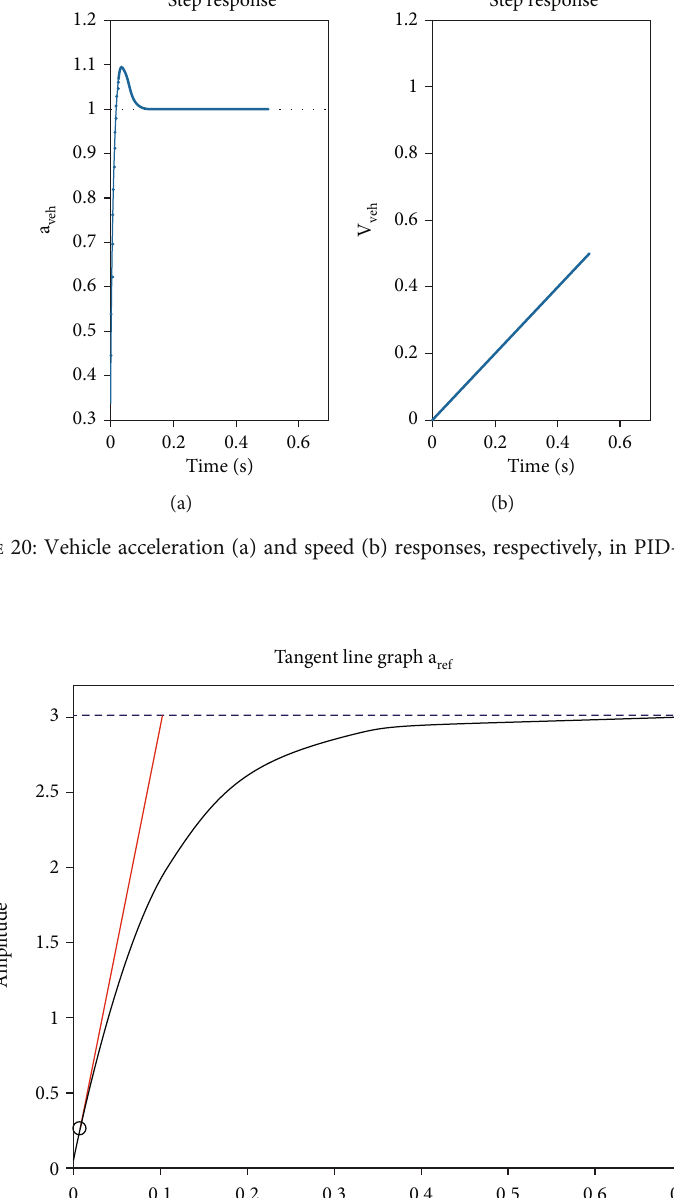
tangent line in closed-loop PID-CC ref